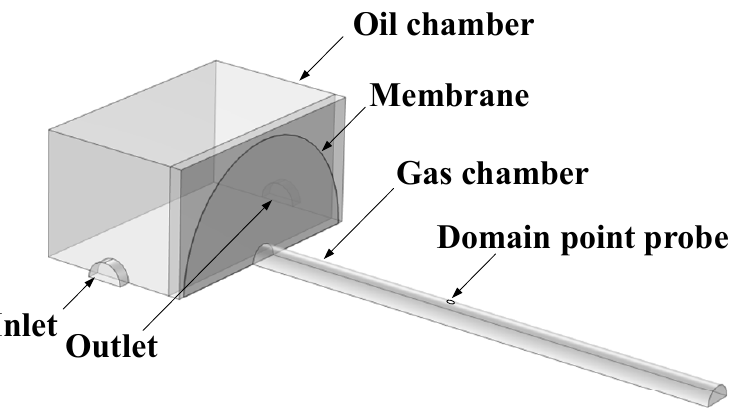
Figure 1. Basic structure of simulation modeling. probe placed in the top center of gas room to detect the concentration of gas.